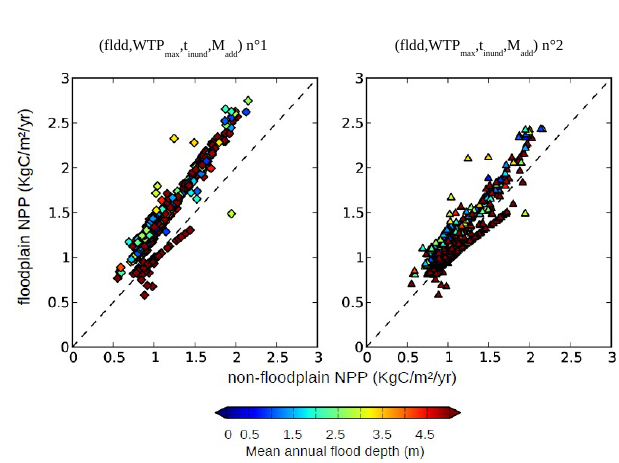
Fig. A7. Same as Fig. 4d except that LPX simulations 1 and 2 (cf. Table 1) are separately plotted. Information about the mean annual flood depth is added (color pallet). The mean annual flood depth is used here as proxy of the NPP inundation-related stress for